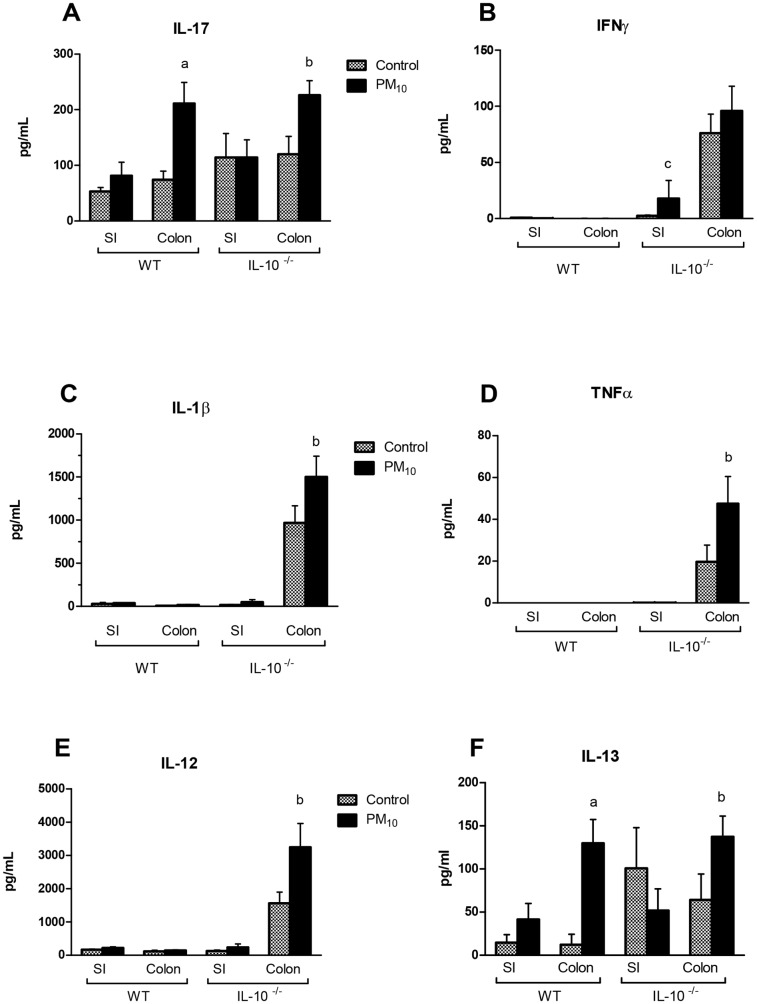
Cytokine expression in small intestine (SI) and colon taken from WT and IL-10−/− mice treated with PM10 for 35 days.A significant increase in IL-17 (A), IL-1β (c), TNFα (D), IL-12 (E) and IL-13 (F) was seen in the colon of IL-10−/− mice treated with PM10. PM10 induced increased IL-17 and IL-13 in the colons of WT mice. Bars are mean ± SEM n = 6–9 for all groups a p<0.05 compared with WT control colon; bp<0.05 compared with IL-10−/− control colon; cp<0.05 compared with IL-10−/− control SI.